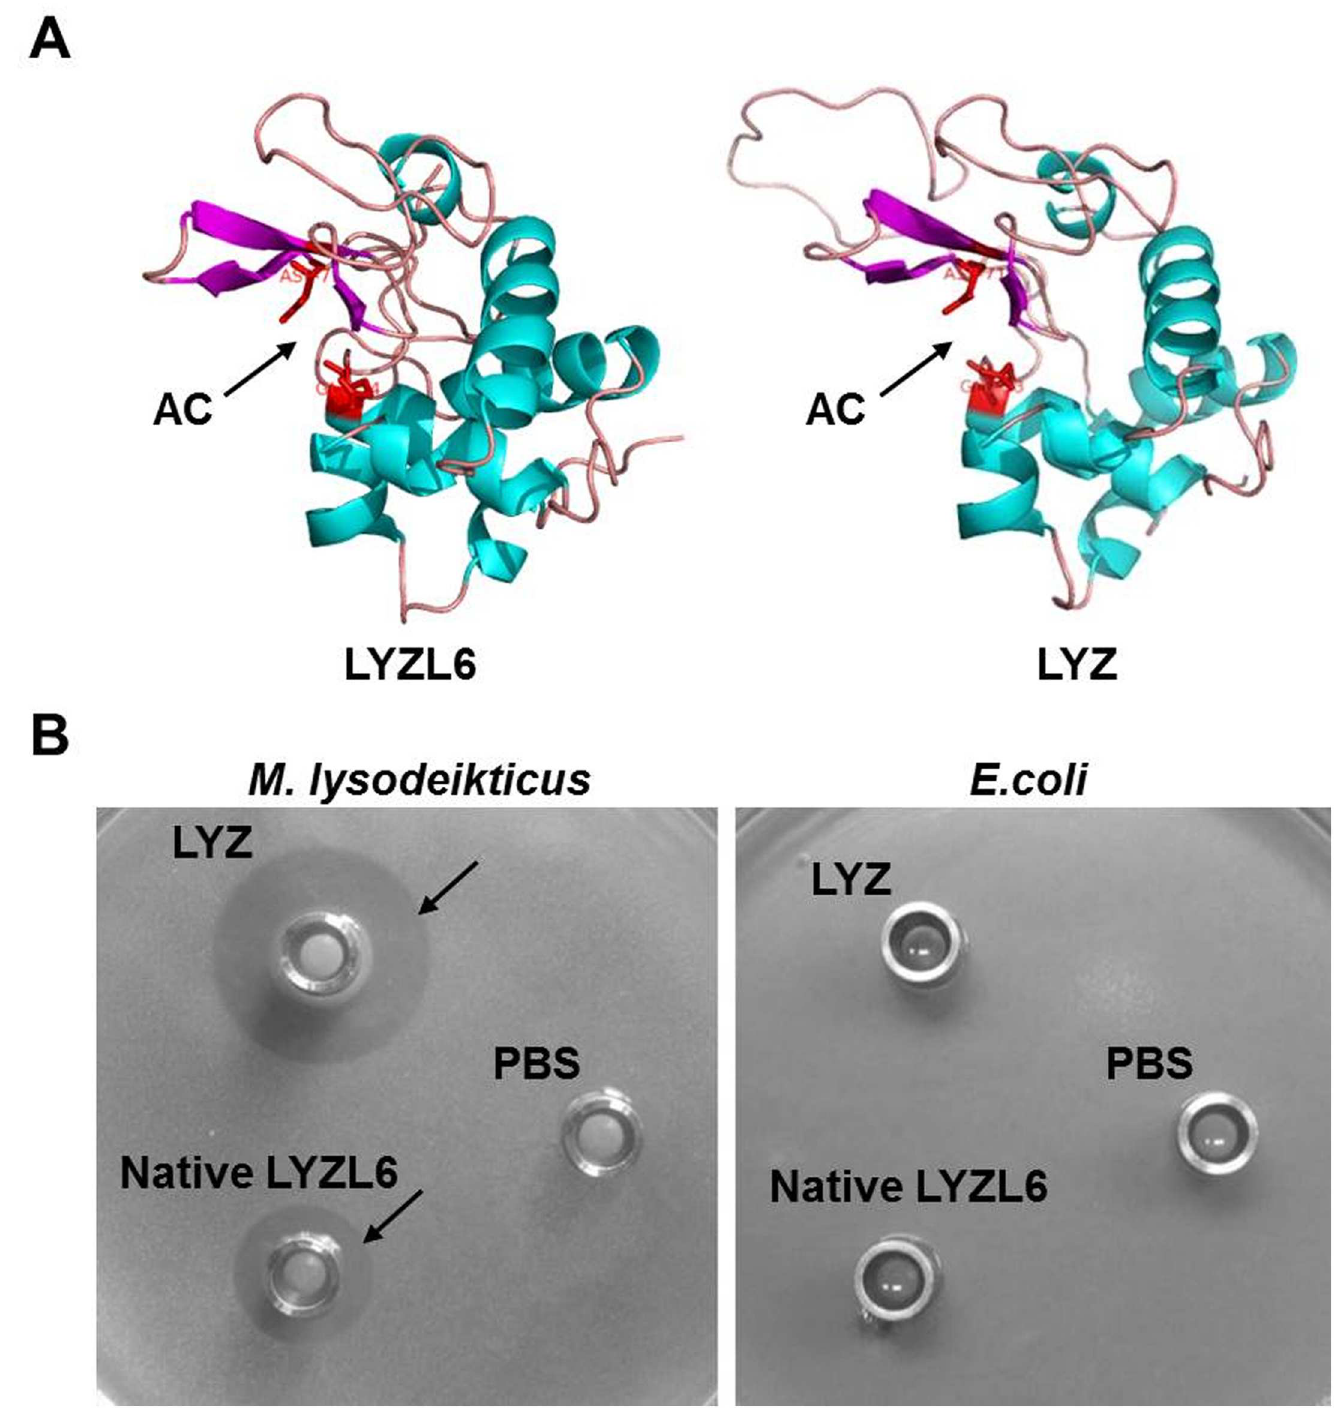
Fig 3. Bacteriolytic activity of LYZL6. A) Homology modeling of LYZL6 and LYZ. The structures of LYZL6 and LYZ were predictedusing MODELLER 9.5. The active centers (AC) of LYZL6 and LYZ were shown (arrows). B) LYZL6 displayedbacteriolytic activity specificallyagainst M . lysodeikticus but not E . coli . Bacteriolytic activity of LYZL6 was assessedusing radial diffusionassay. Native LYZL6 in PBS (pH 6.0) was added to wells and the zone of clearance was observedusing M . lysodeikticus (arrow), but not using E . coli as substrate. LYZ was used as a positive control and PBS was used as a